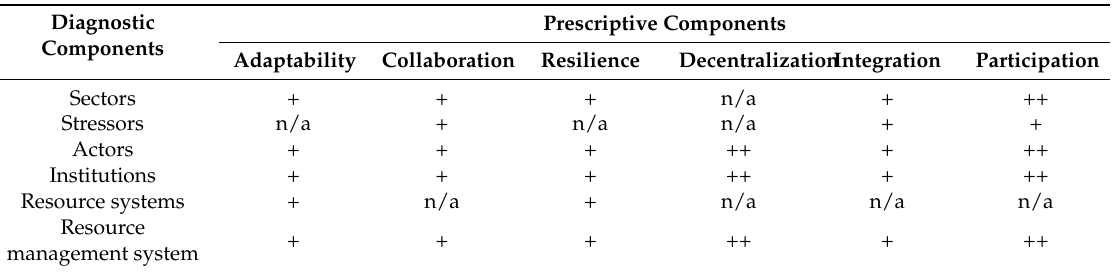
Table 2. Summary of Songkhla Lake Basin governance performance